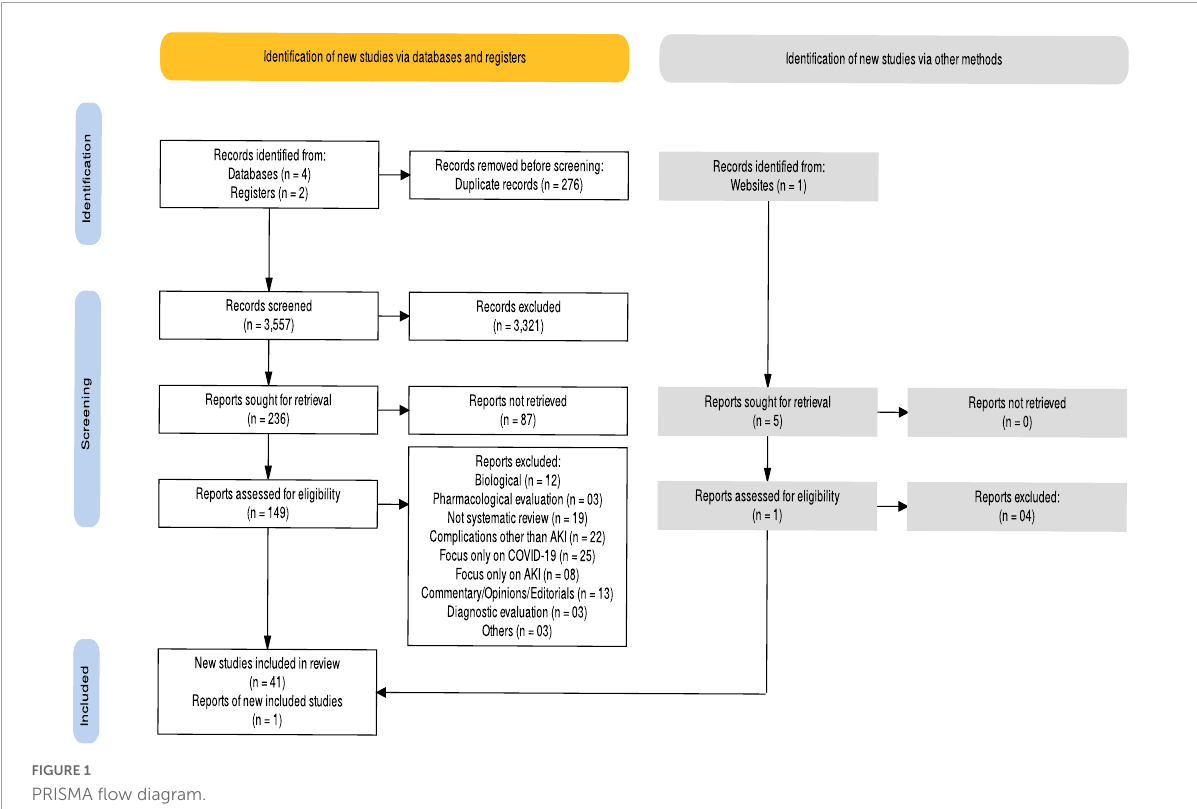
FIGURE1 PRISMA flow